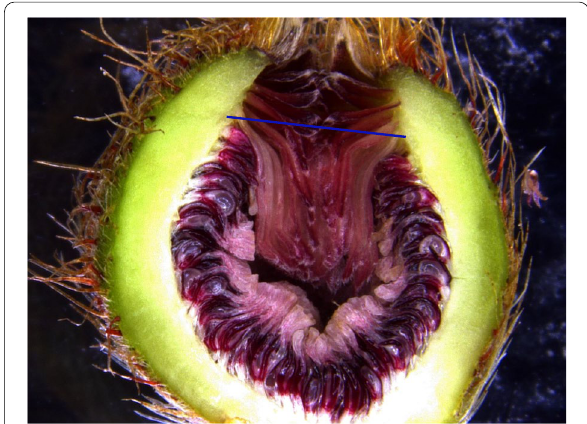
Fig. 2 The syconia of F. hirta showing the measure of the ostiole diameter. The length of the blue line represent the ostiole diameter